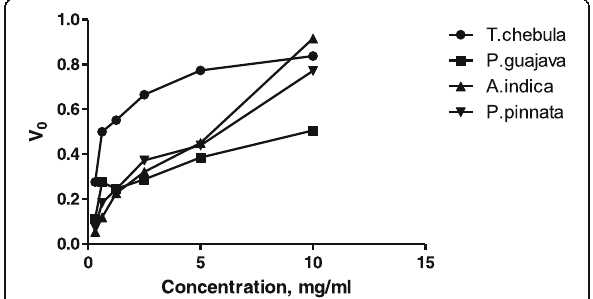
Fig. 4 Exponential response curves of T.chebula, P.guajava, A.indica and P.pinnata extracts